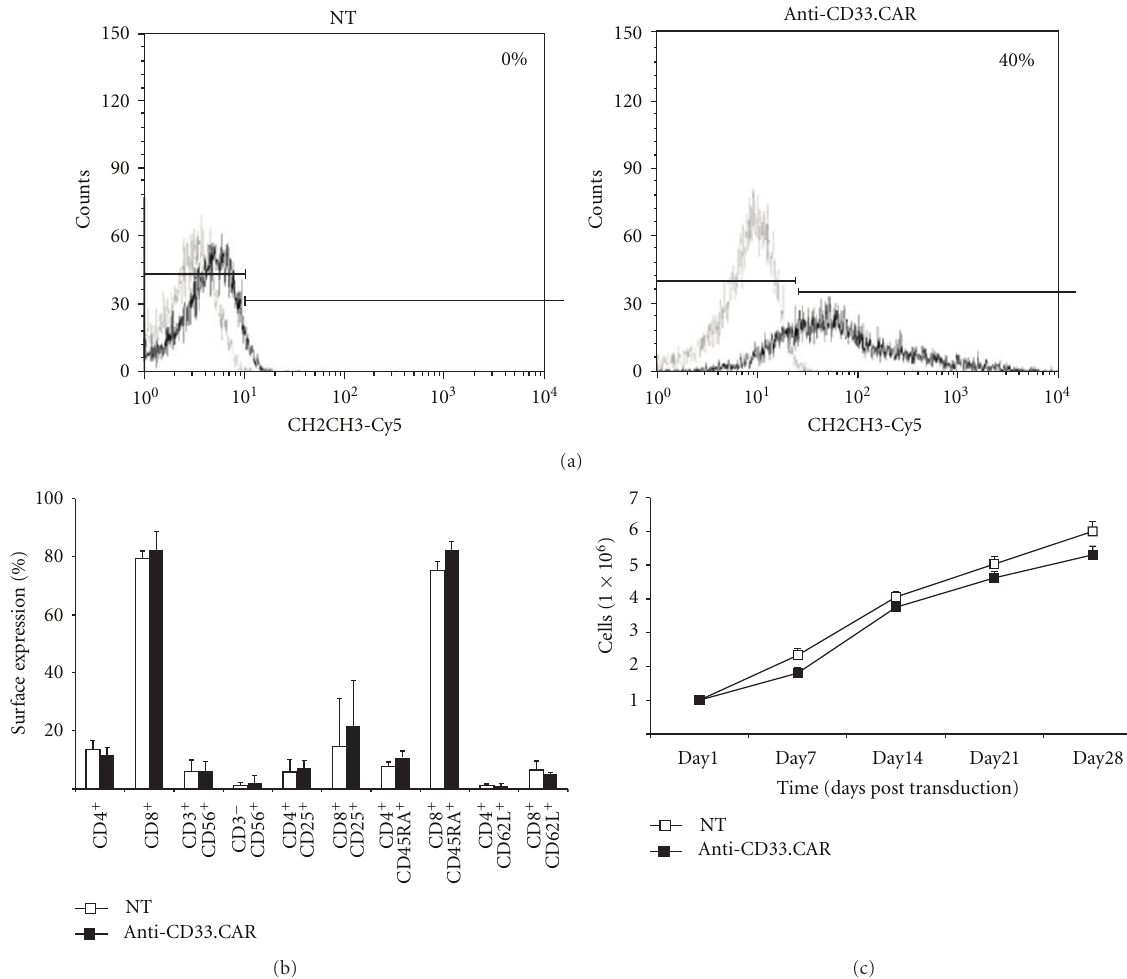
Figure 1: EBV-CTLs could be stably transduced with the anti-CD33.CAR without alteration in their native immunophenotype and expansion rate. (a) The expression of the anti-CD33.CAR on the surface of EBV-CTLs was evaluated by flow cytometry with a Cy5- conjugated-mAb specific for the CH2CH3 domain of the CAR after 7 days of culture. A representative plot of EBV-CTLs transduction after 7 days of culture is shown. (b) The expression of CD4, CD8, CD3 along with CD56, CD4, and CD8 along with CD25, CD4, and CD8 along with CD45RA, CD4, and CD8 along with CD62L on the surface of EBV-CTLs was evaluated after 30 days of culture by flow cytometry. (c) Proliferation of anti-CD33.CAR-transduced EBV-CTLs compared to unmanipulated EBV-CTLs was evaluated by cell count with Trypan blue exclusion after weekly stimulations at 4:1 ratio with either irradiated autologous LCLs. Cells were cultured with low-dose rhIL-2 (20U/mL). Data shown are mean ± SD of 6 separate